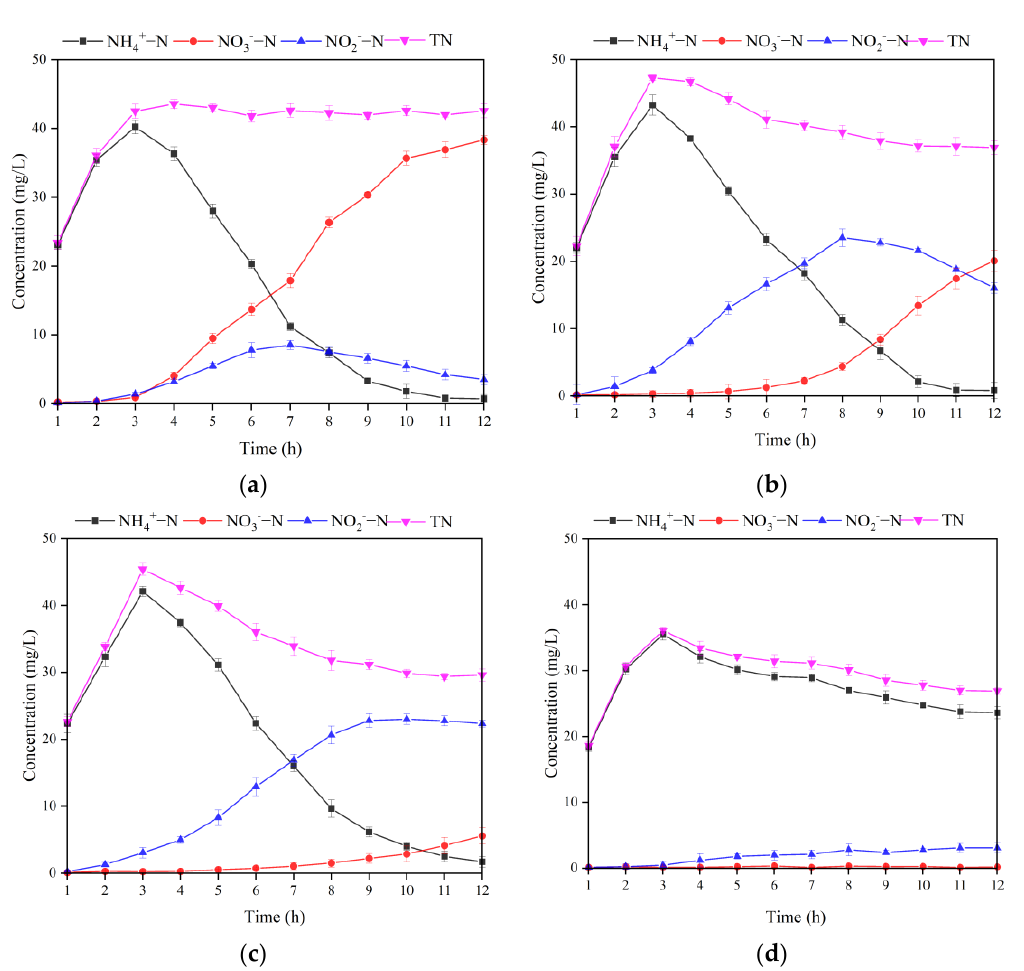
Figure 8. Changing of different forms of nitrogen under different DO levels in MBBR. ( a ) 3 mg/L;